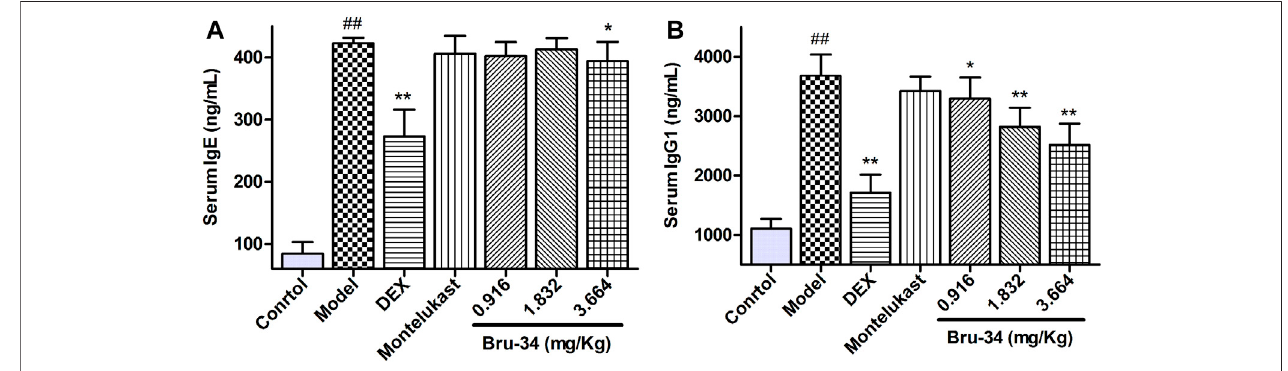
FIGURE 2 | Bru-34 decreased the levels of IgE and IgG1 in serum. Panel (A) : The level of serum IgE; Panel (B) : The level of serum IgG1; Data were expressed as mean ± S.D., n (cid:2)